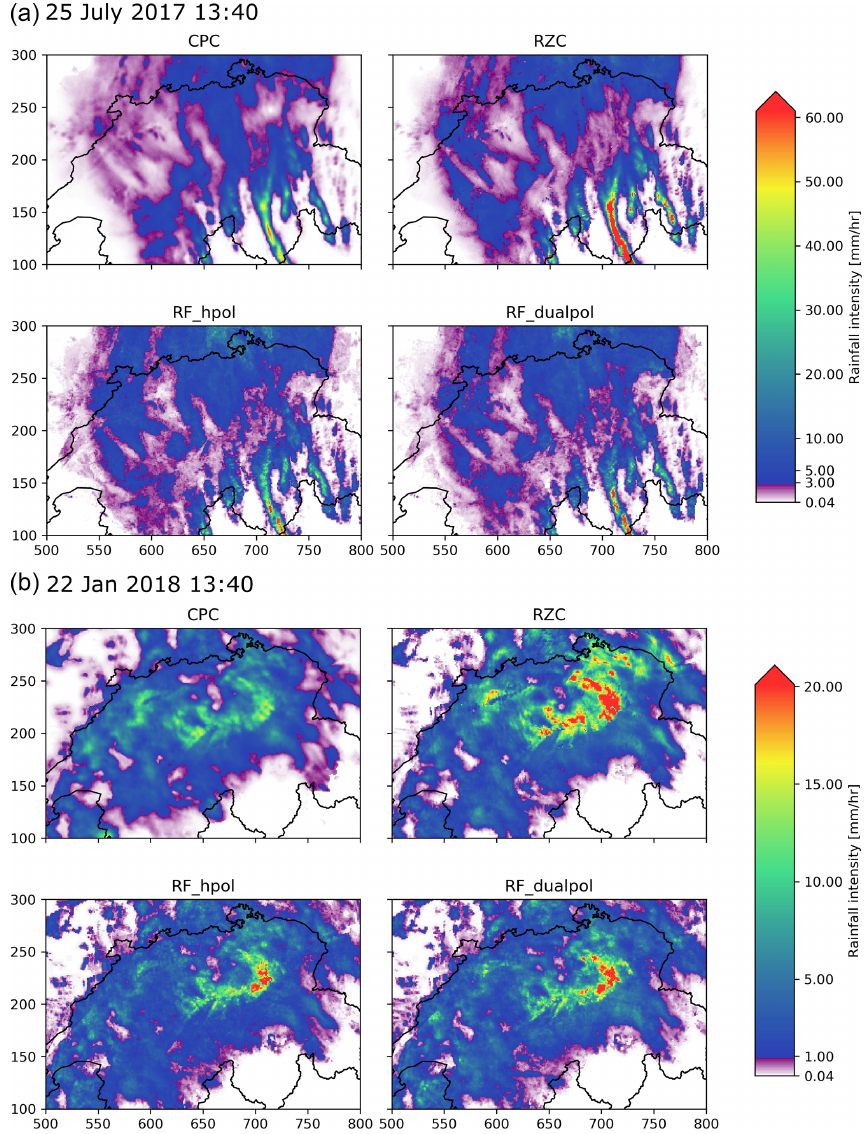
Figure 14. Two examples of precipitation fields generated with RZC, CPC, RF_dualpol and RF_hpol (both with Gaussian smoothing): (a) strong convection on 25 July 2017 during a typical summertime barometric swamp. The color scale is divided in a linear progression in purple tones for low precipitation and a logarithmic progression from blue to green above a certain threshold. (b) Heavy snowfall event during a warm front crossing of Switzerland on 22 January